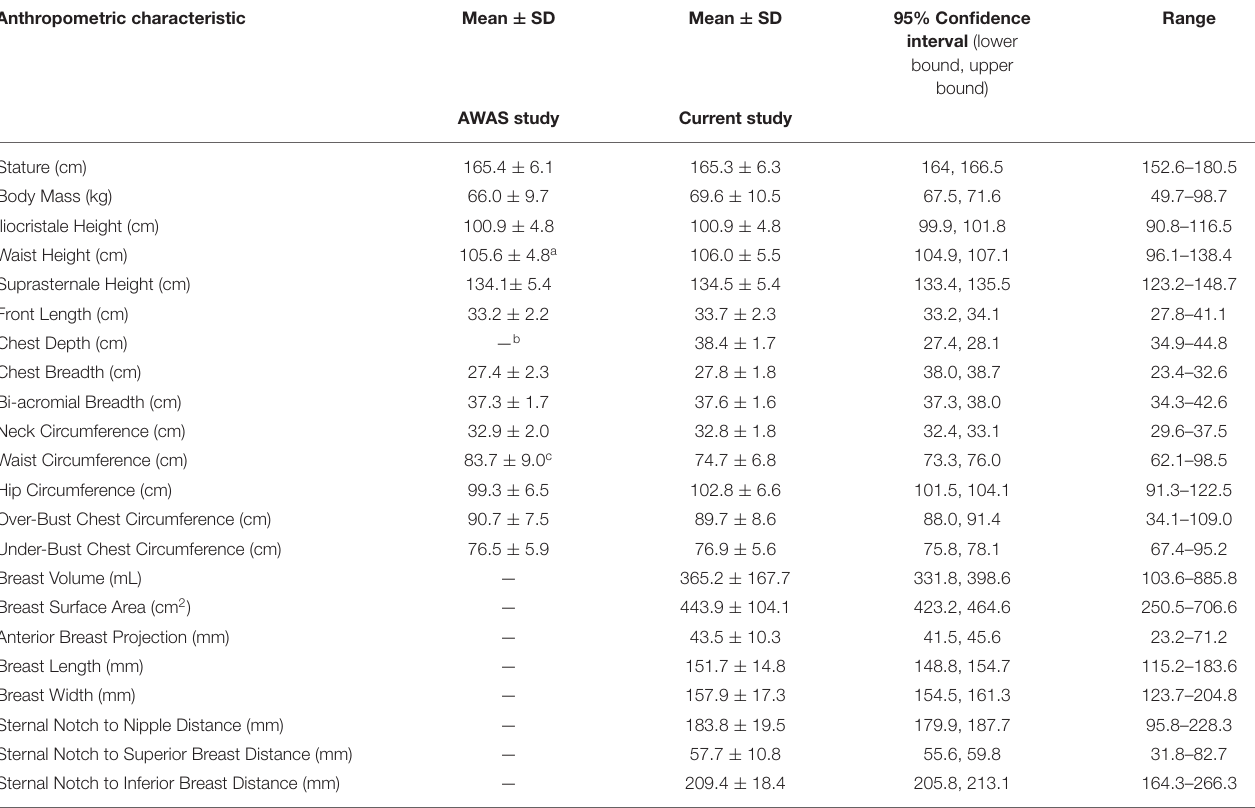
TABLE 4 | Torso and breast characteristic data (mean ± standard deviation, confidence interval, and range) of the study participants ( n = 97) are shown. Anthropometric characteristic